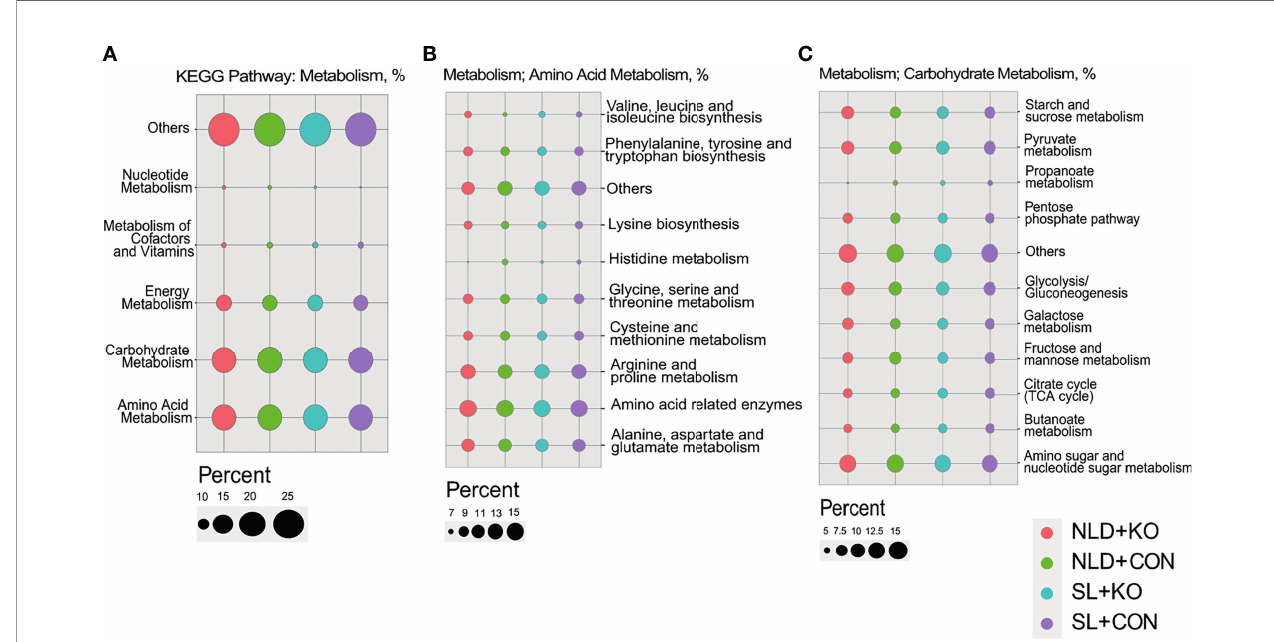
FIGURE 8 | Predicted of bacterial functions of KEGG pathway via PICRUSt2 in KO and CON mice under NLD and SL. KO, Per2 gene knockout ( Period2 − / − ) mice; CON, wild-type ( Period2 +/+ ) mice; NLD, normal light – dark cycle treatment of 12 h light and 12 h darkness; SL, short-light treatment of 8 h light and 16 h darkness. (A) The bacterial functional predictions of KEGG secondary pathway via metabolism. (B) The amino acid metabolism pathways predicted via metabolism. (C) The carbohydrate metabolism pathways predicted via metabolism. n = 6 per group for 16S rRNA